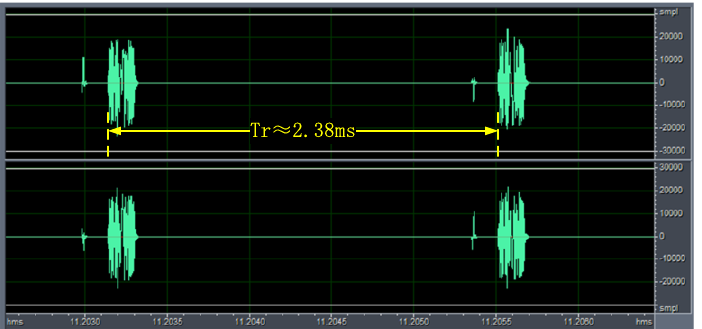
Figure 15. The collected IQ data of the surveillance channel with multiple pulse repetition periods after partial magnification.